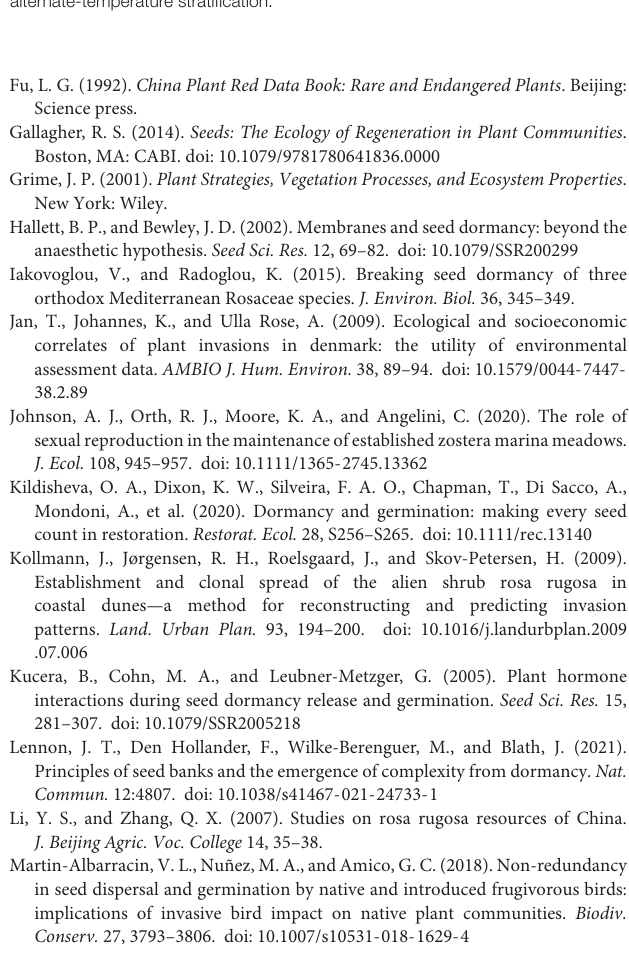
Supplementary Figure 1 | Methods of mechanical scarification. Front view (A) and side view (B) of seed with full endocarp, scratching (C) , piercing (D) , or (E) peeling of seed endocarps. Supplementary Figure 2 | After natural drying, the water absorption rate of intact seeds or seeds with endocarp removed was investigated. Supplementary Figure 3 | Soluble sugar (A) , starch (B) , and protein contents (C) of embryos during stratification for 0, 30, 60, and 90 days at 4 ◦ C. Supplementary Figure 4 | Seed germination percentage were calculated without damage or with scratching, piercing, or peeling of seed endocarps. Supplementary Figure 5 | Seed germination percentages were calculated after exogenous GA 3 treatment. Supplementary Table 1 | Physiological indices of Rosa rugosa seeds under alternate-temperature